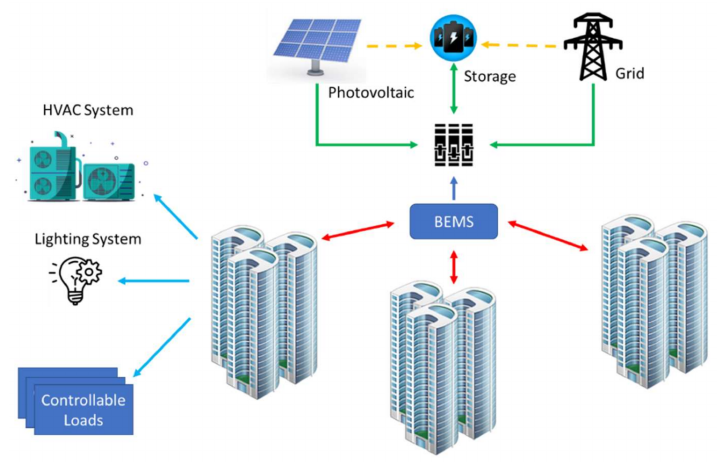
Figure 2. Illustration of a BEMS with controllable loads and